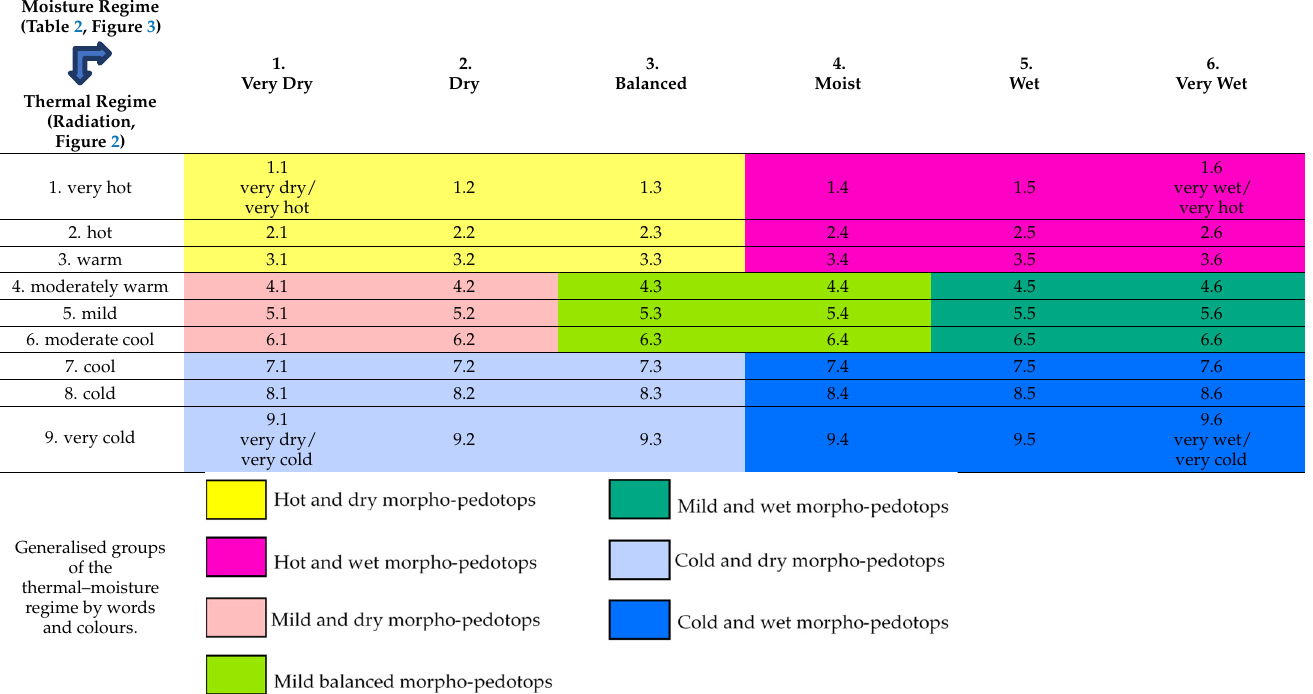
Table 2. Relative values of the moisture regime and morpho-pedotop topographic humidity. (Moisture regime of the